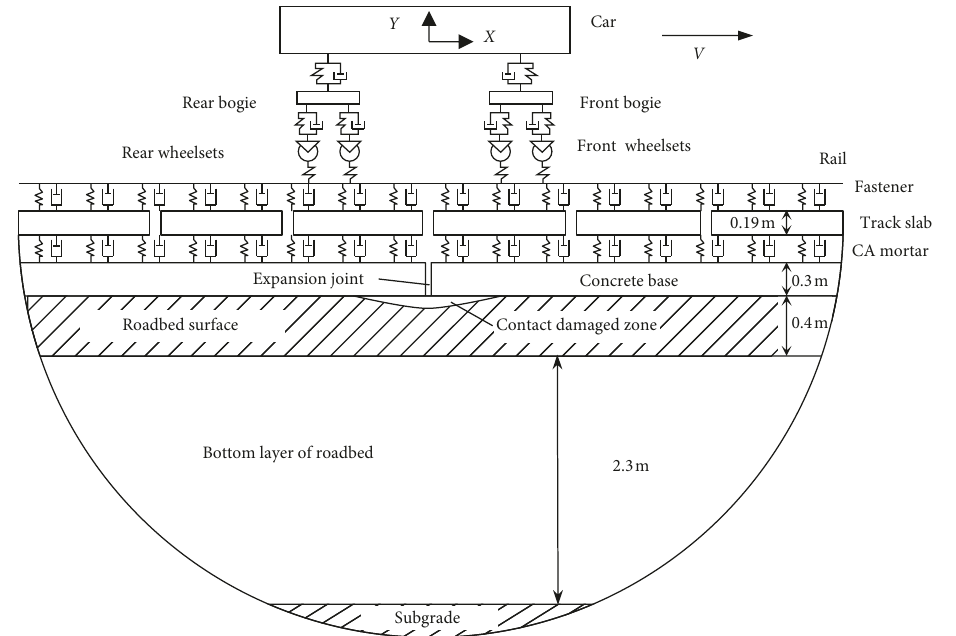
Figure 2: Key components of vehicle-track-subgrade vertical coupling vibration model. Table 1: Basic parameters of vehicle